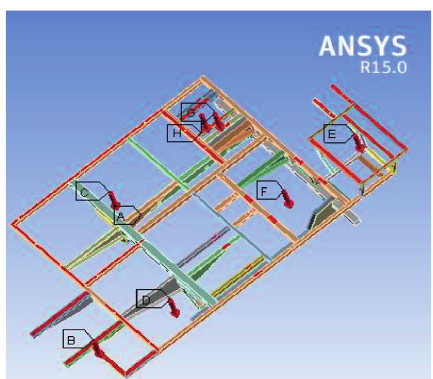
Figure 10: Load distribution on the chassis